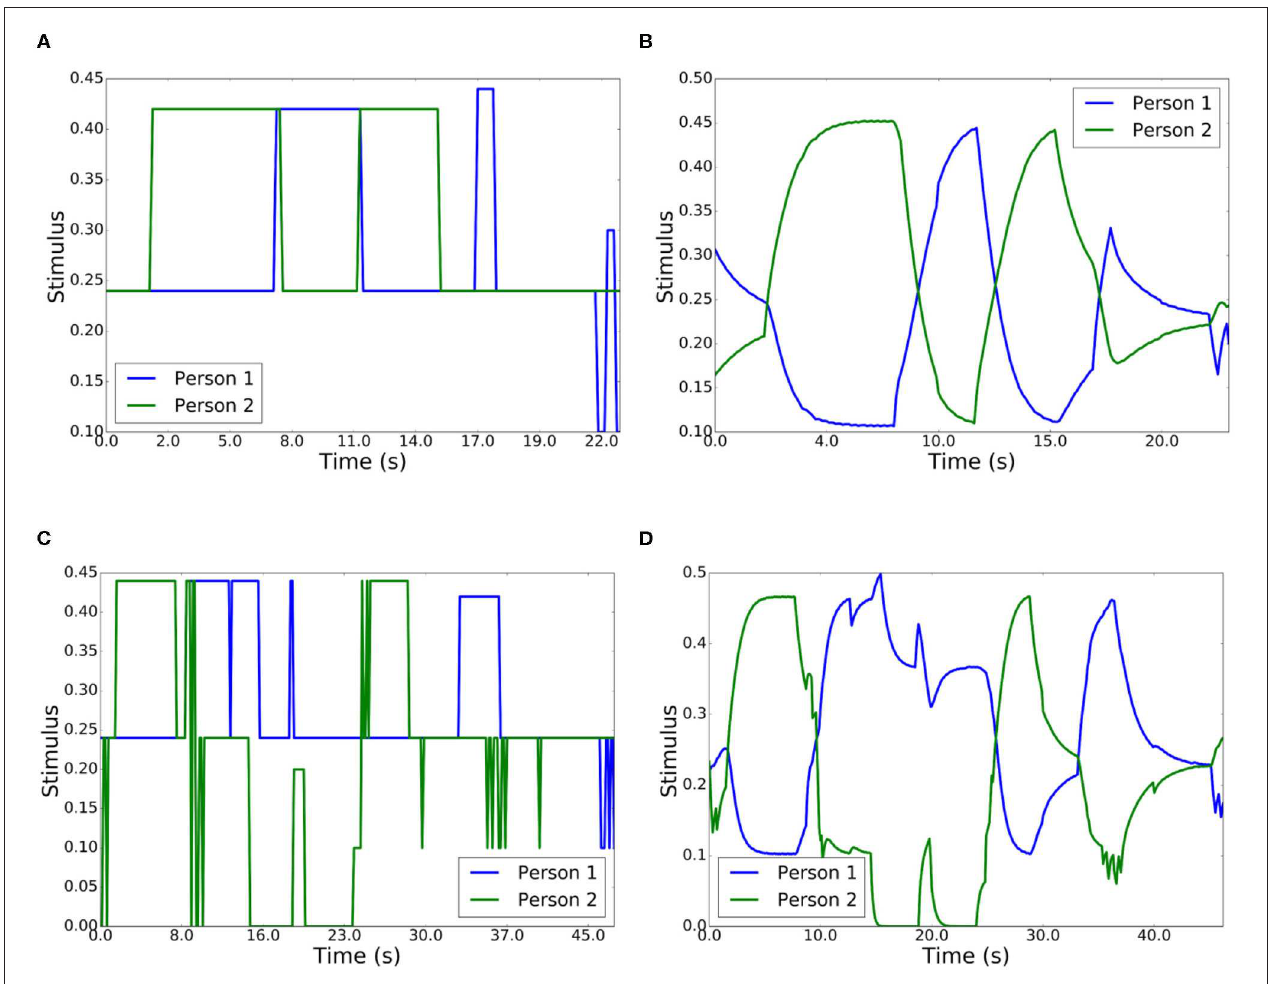
FIGURE 10 | Robot interaction with two people. (A) Input stimuli in a conversation. (B) Output stimuli in a conversation. (C) Input stimuli with different actions. (D) Output stimuli with different actions.